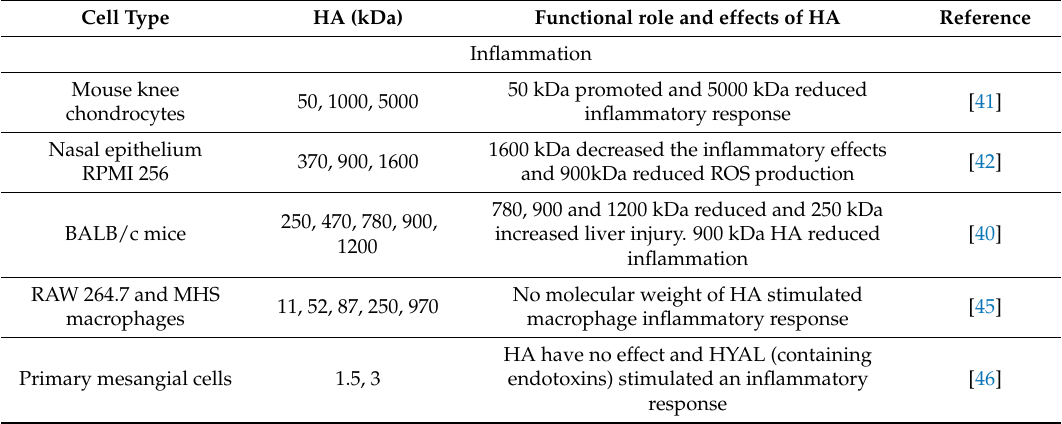
Table 1. Range of studies analyzing physiological role of exogenous hyaluronan (HA) of known molecular